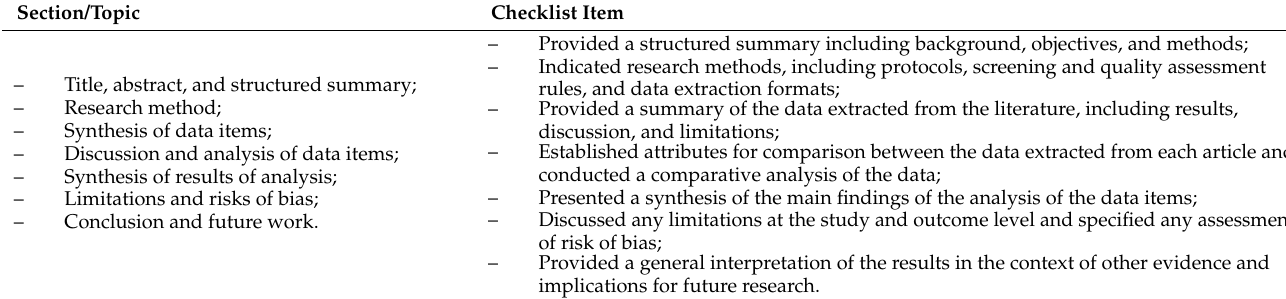
Table 2. Sections and topics included in the composition of the systematic review based on the checklist of items proposed in